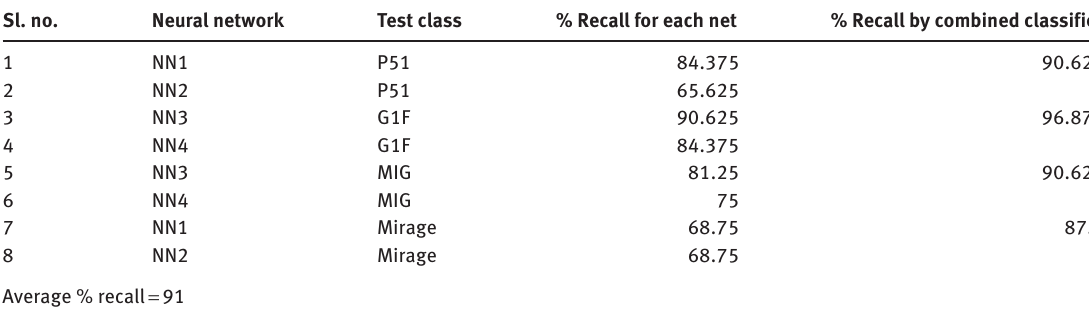
Table 4: Percentage Recall for Test Class.